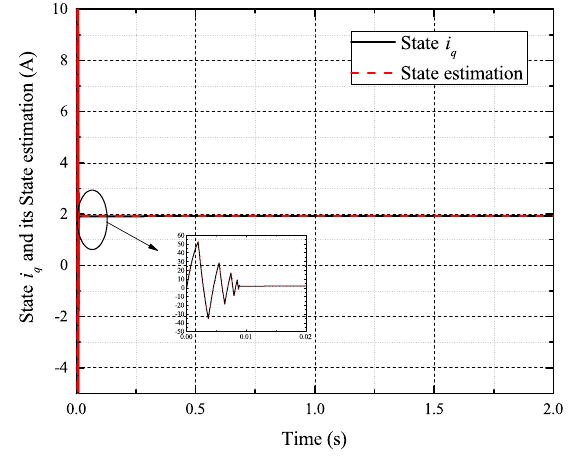
Figure 11. State i q and its estimated value ˆ i q .